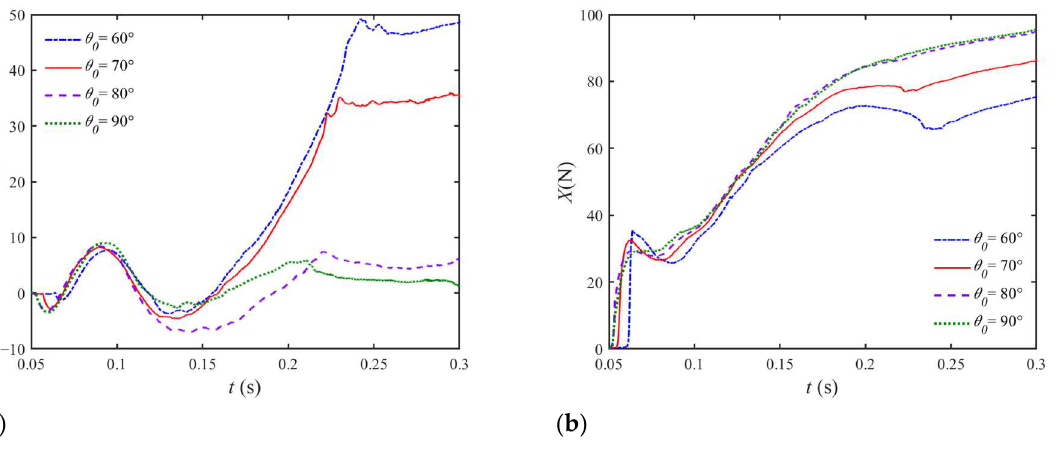
Figure 20. Comparison of time history curve of ( a ) transverse force and ( b ) lateral force for the water entry of UAUV with different initial pitch angles.